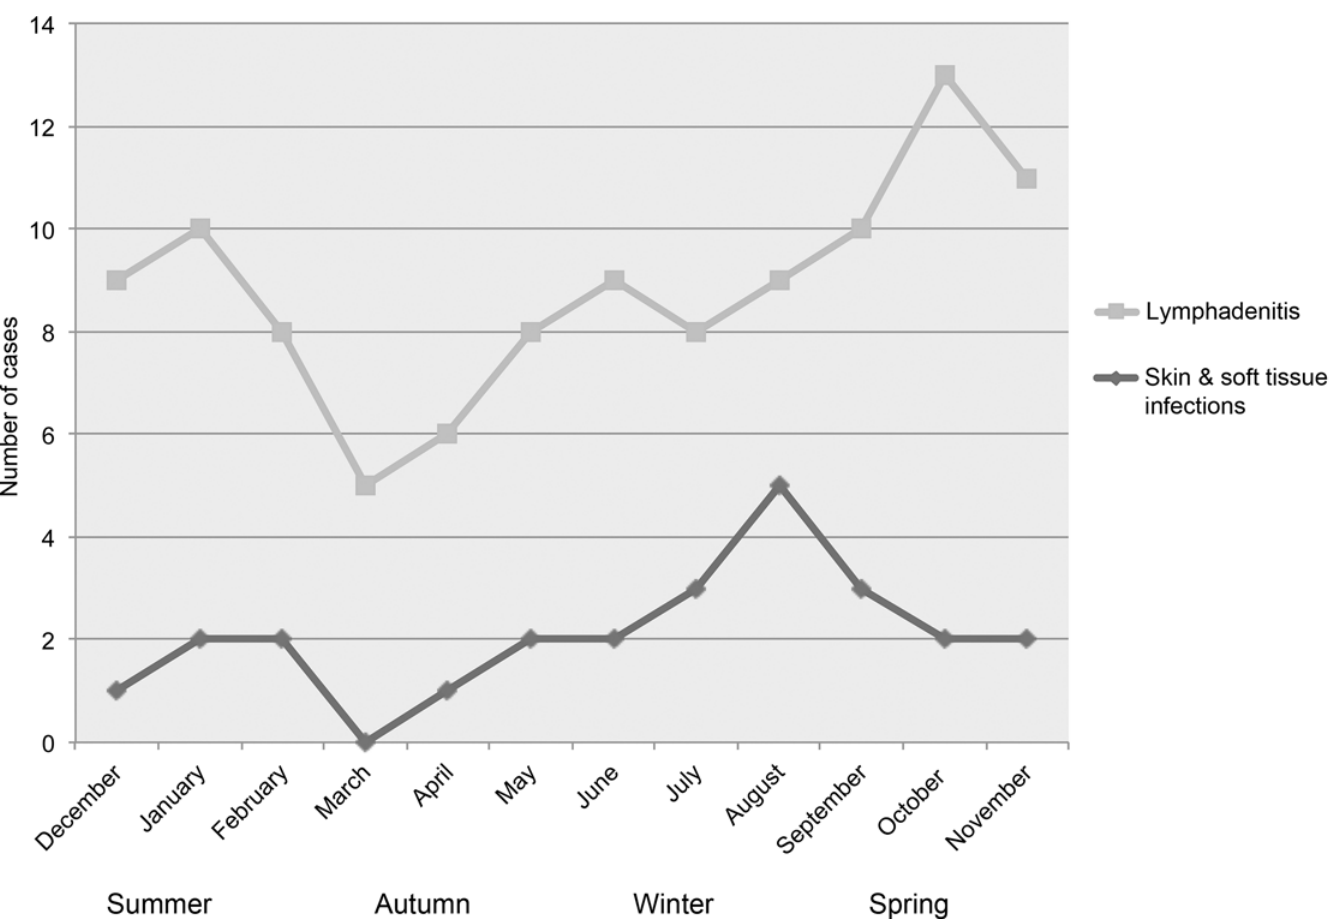
Fig 1. Seasonal distribution of nontuberculous mycobacterial lymphadenitis and skin and soft tissue infections over the study period according to the month of initial presentation.